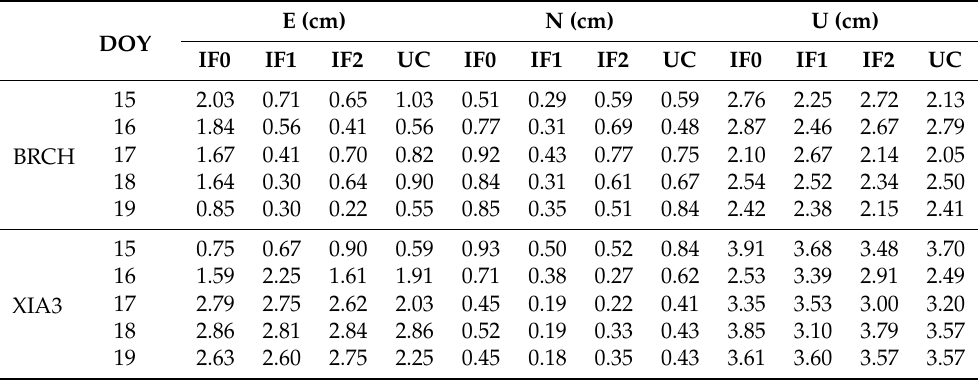
Figure 17. Position error between different BDS-3 PPP methods at XIA3. Table 7. The RMS values of the position error for BRCH and XIA3 stations with different BDS-3 PPP models